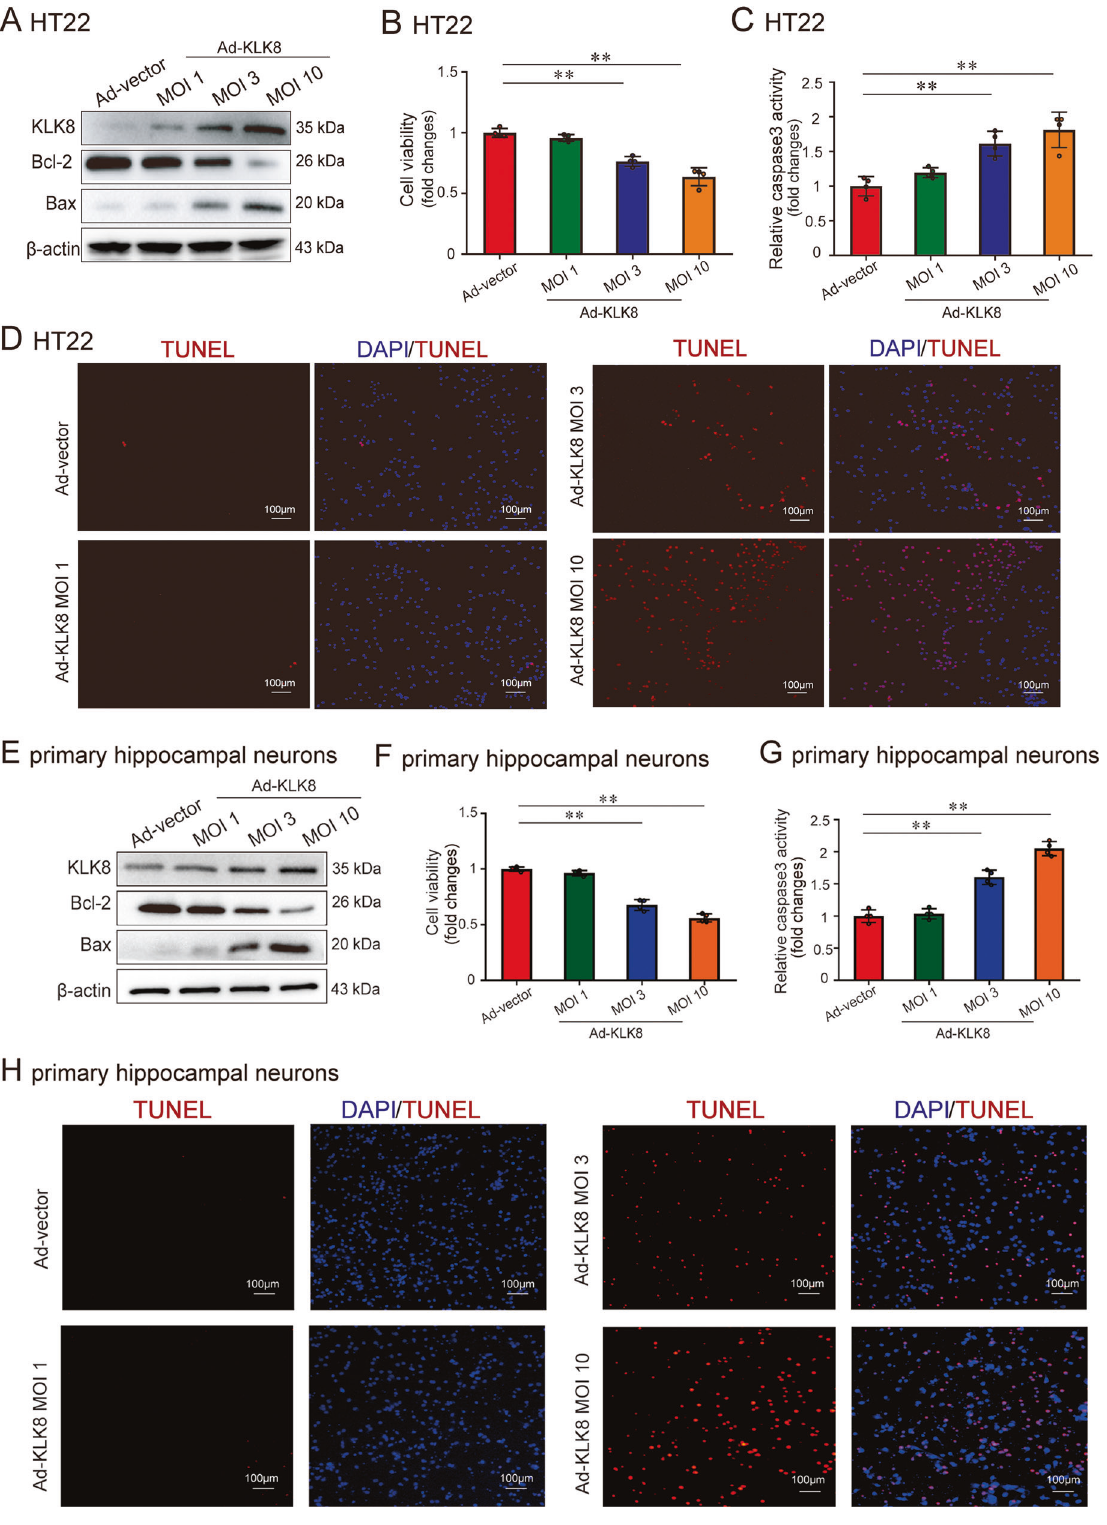
and the percentage of TUNEL-positive cells (Fig. 3B, C), while the expressions of Bcl-2 (Fig. 3A) was notably decreased in